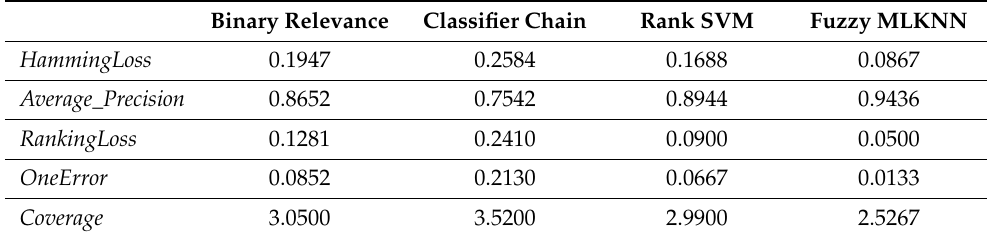
Table 8. Performance comparison between different multi-label